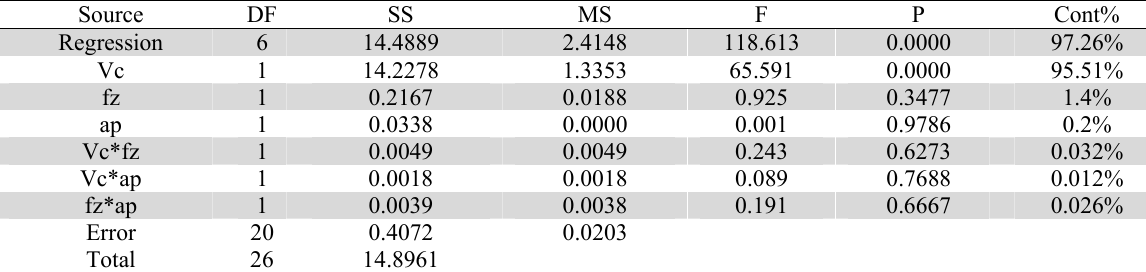
Analysis of variance for the surface roughness Ra